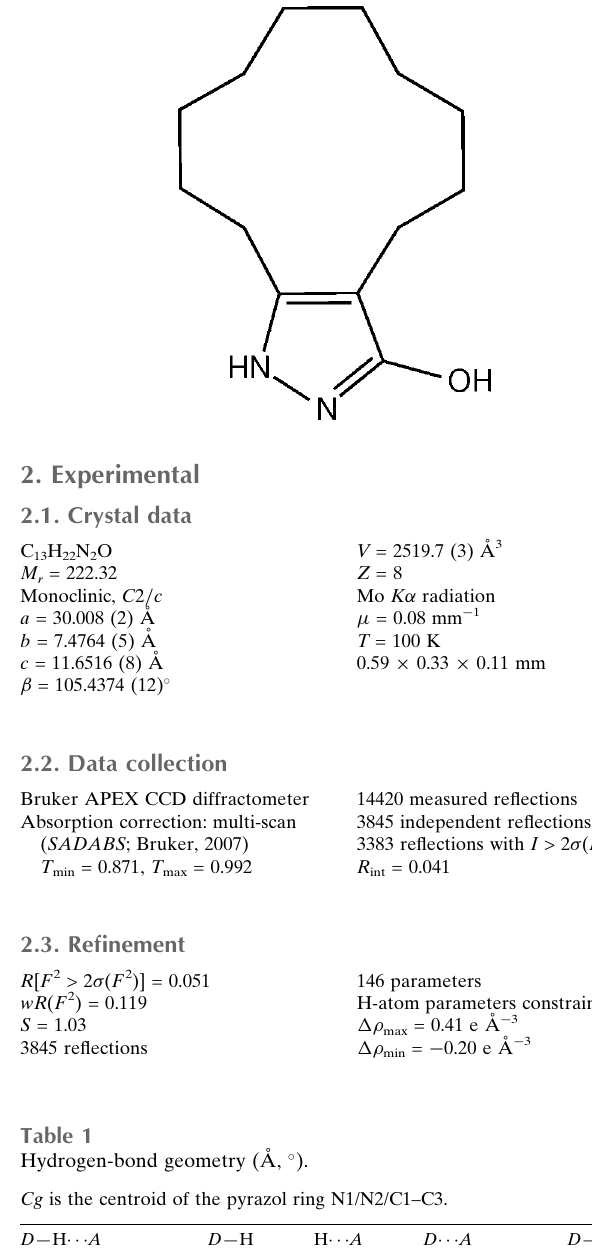
Hydrogen-bond geometry (A˚ , (cid:3) ). Cg is the centroid of the pyrazol ring